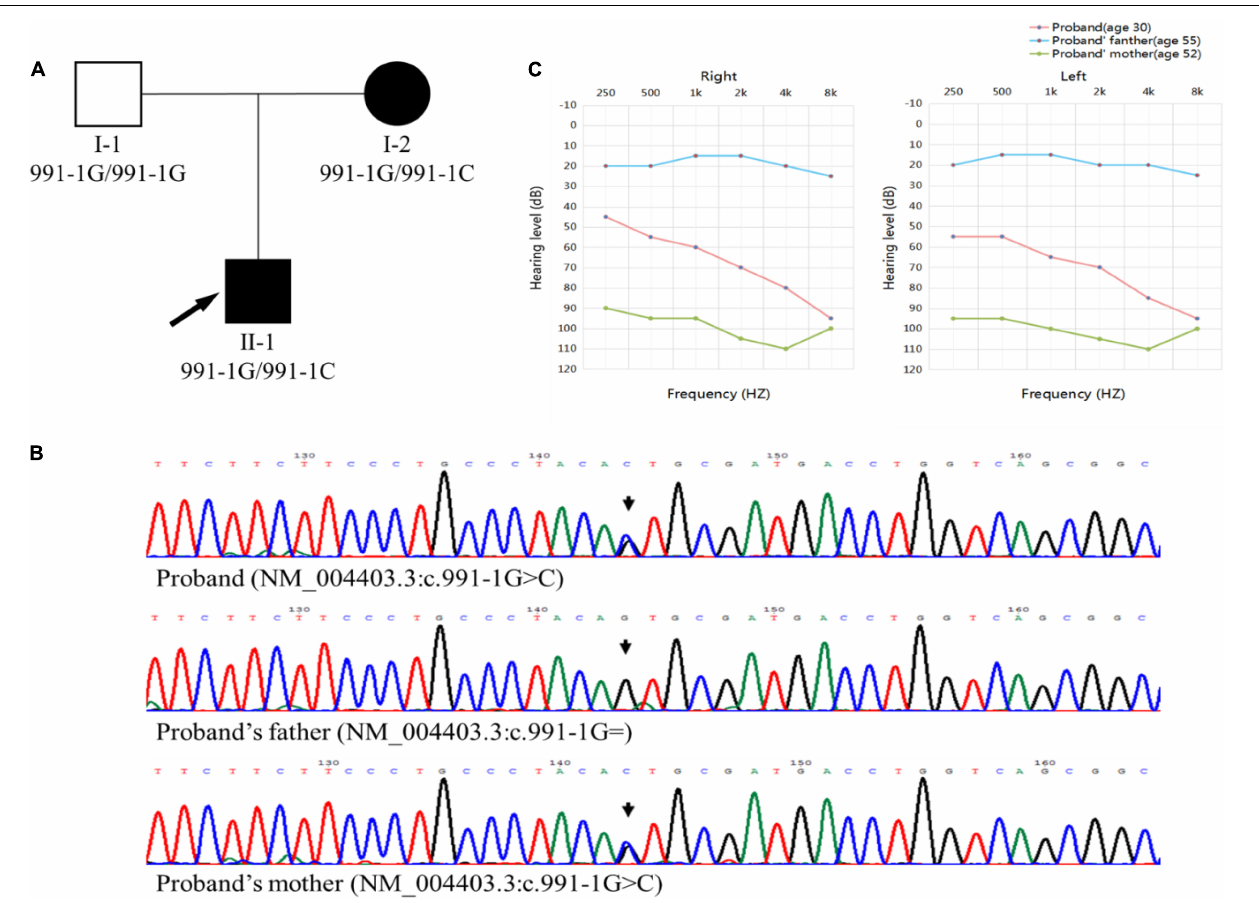
FIGURE 1 | (A) Pedigree chart. The affected members are indicated by filled symbols, and the unaffected member is indicated by an open symbol. The arrow and indicates the proband. (B) Sanger sequencing chromatograms, identifying the c.991-1G > C mutation in the proband (II-1) and his mother (I-2) and wild-type c.991-1G in the proband’s father (I-1). (C) Audiograms of the family members. The charts present the data for the right and left ears of every participant, respectively. The red line represents the proband, and the blue and green lines represent proband’s father and mother,